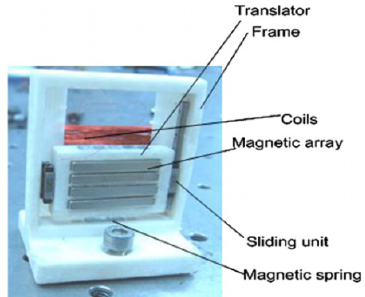
Figure 2: Magnetic-inductive energy harvester [11]: 54x46x15mm 3 size, 0.55mW output power at 9.25Hz frequency and 0.8g